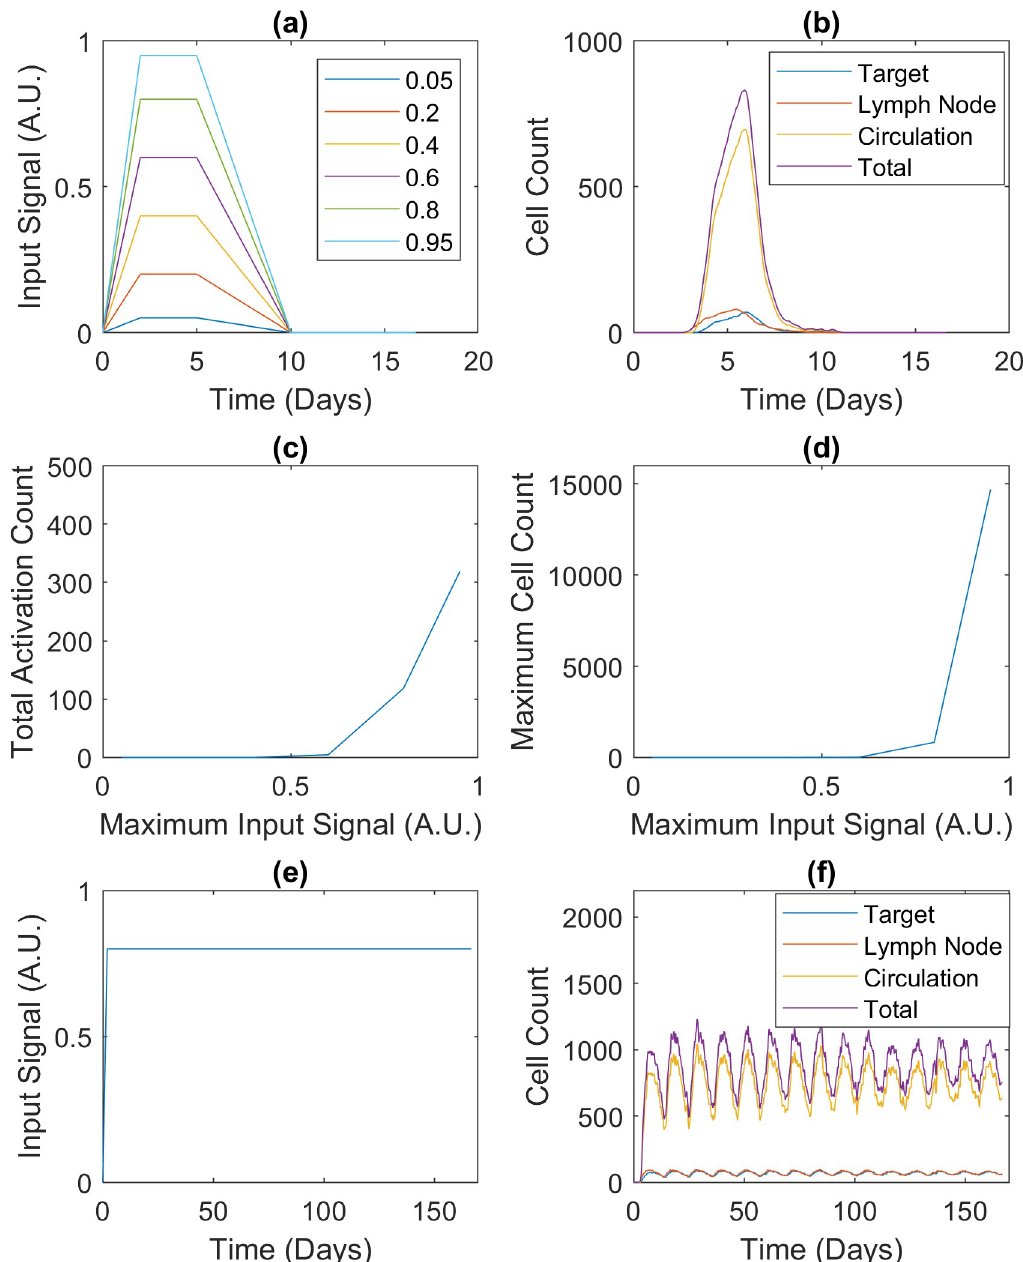
Fig 6. CD4+ T cell responses to different infections. CD4+ T cell responses involve effectors and reactivated memory cells only. All cell counts are averages over 50 realizations. (a) Input signals representing acute infections with different peaks. The signal strength is in arbitrary units (A.U.). The signal labeled 0.8 represents the viral trajectory from an experimental study about influenza [20] and is known as the default input signal in this paper. (b) Population dynamics in response to the default input signal. (c) and (d) Total counts of naive cell activation and maximum cell counts corresponding to the input signals in (a). (e) Input signal representing a hypothetical chronic infection. (f) Population dynamics in response to the input signal in (e). Details about the signals and simulations can be found in Methods and S1